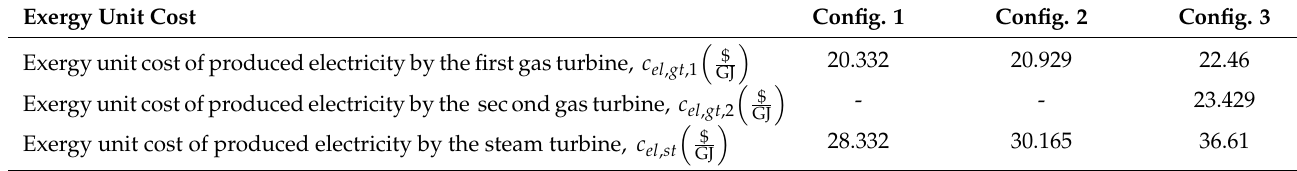
Table 15. Unit cost of exergy for the produced electricity by turbines in all